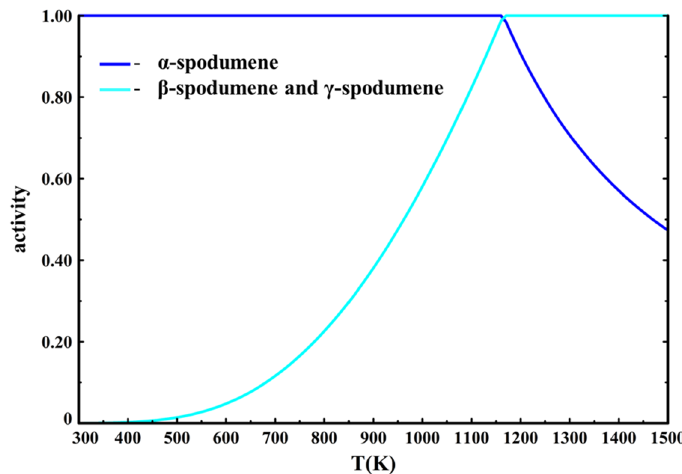
Figure 12. Activity diagram for α -spodumene, β -spodumene, and γ -spodumene using Konar’s data [15] for α -spodumene and β -spodumene in the four-element system (Li + Al + 2Si + 3O 2 ). According to Fasshauer’s [42] assumption, γ -spodumene is assumed to have the same parameters as β -spodumene.